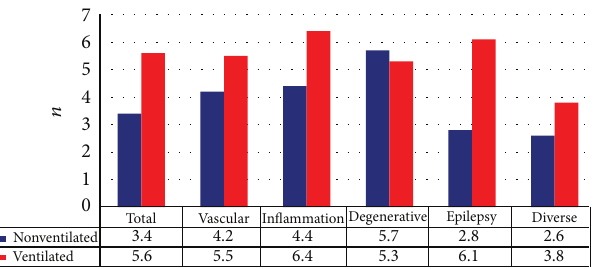
Figure 3: Diagnostic procedures/patient.